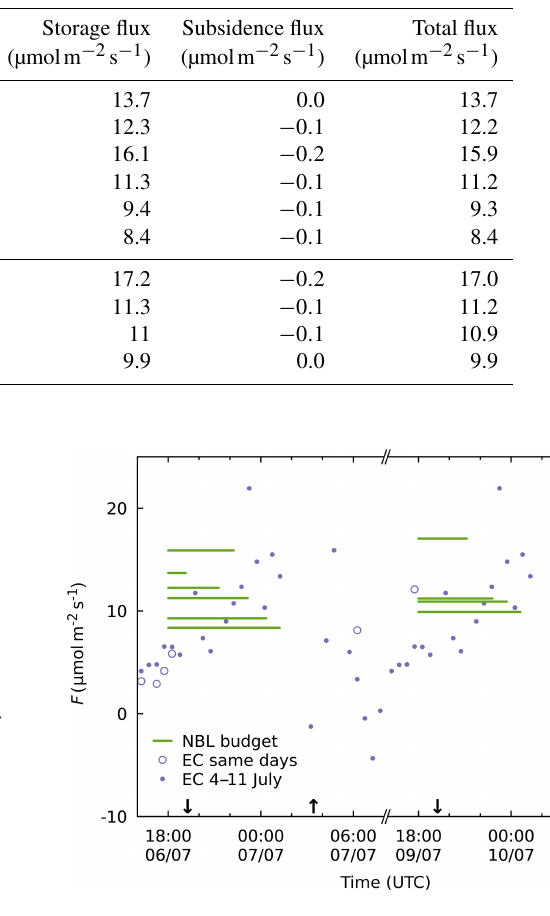
Figure 11. Comparison of vertical CO 2 fluxes F calculated from the NBL budget and using the EC method. The fluxes from the NBL budget are depicted as lines, where the vertical position of each line represents the average flux over the time span specified by the horizontal extent of the line. Open circles represent the quality-filtered EC measurements taken on the same days as the NBL measurements. Solid dots represent the mean diurnal cycle of the quality-filtered EC measurements averaged over the period from 4 July 2016, 00:00UTC, to 11 July 2016, 23:59UTC. Upward and downward arrows mark the time of sunrise and sunset, respectively. NBL and EC agree in magnitude of NEE at night but not in sign of